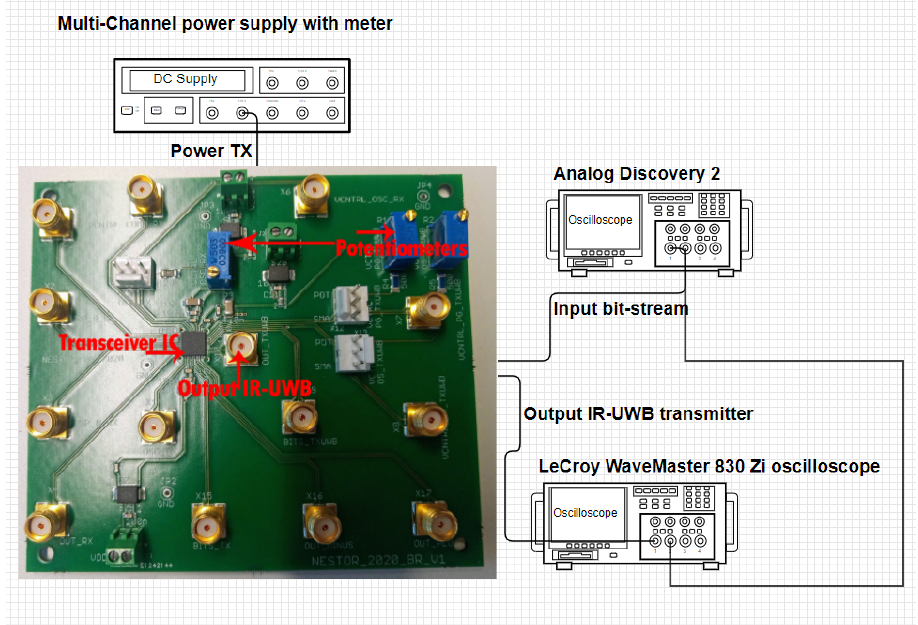
Figure 10. Block diagram of experimental test setup for the IR-UWB transmitter with the demonstra- tor board as picture, the rest of the setup as a diagram.